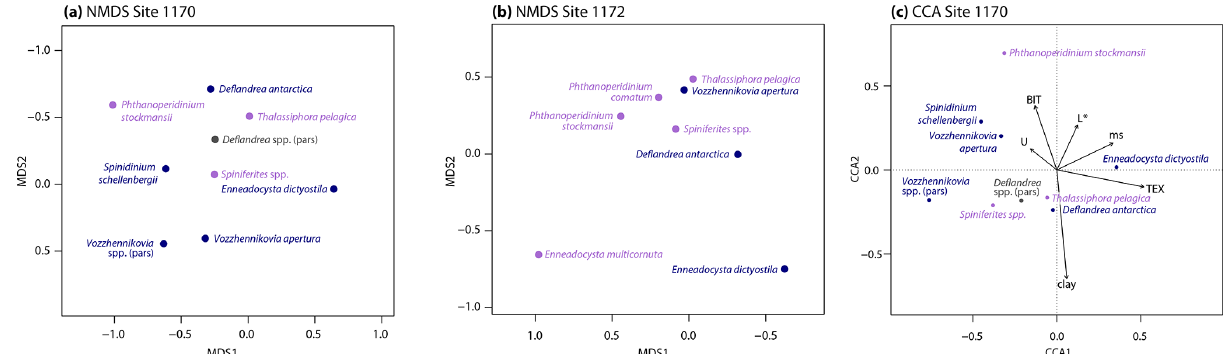
Figure 4. Ordination results. (a) Nonmetric multidimensional scaling ordination diagram for the dinocyst assemblage data of Site 1170. Species scores as circles and color-coded by biogeographic affinity (purple, cosmopolitan; blue, endemic; gray, not assigned). (b) Nonmetric multidimensional scaling ordination diagram for the dinocyst assemblage data of Site 1172. Species color coding as in (a) . (c) Canonical correspondence analysis ordination diagram for the dinocyst assemblage data of Site 1170. Species color coding as in panel (a) . Abbreviations are as follows: BIT, BIT index; clay, clay fraction (%); L ∗ , CIELAB lightness variable; ms, magnetic susceptibility; TEX, TEX 86 ; U, uranium content. Total percentage of inertia in species data explained by environmental variables is 34%. For visual clarity, only the most abundant taxa (taxa that occur in > 10% of the samples, have a mean relative abundance > 1%, and have a maximum relative abundance of > 5%) are shown in all three panels. Ordination plots showing all taxa are provided as Fig.